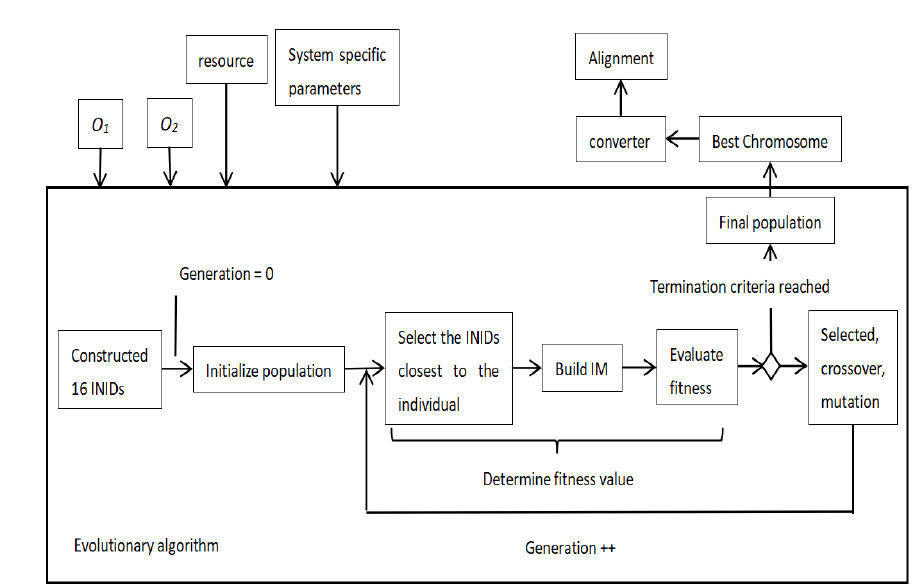
Figure 5. The framework of EA-IM based ontology